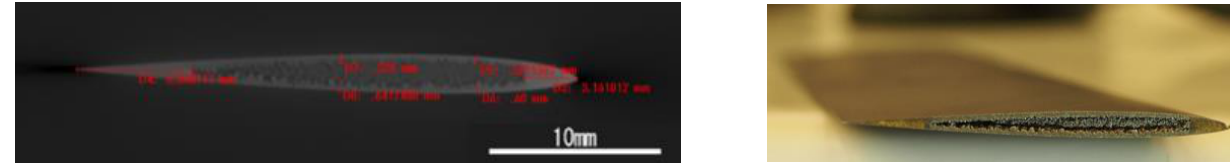
Figure 8. CT scan ( left ) and picture ( right ) of the cross-section of the flutter wing.